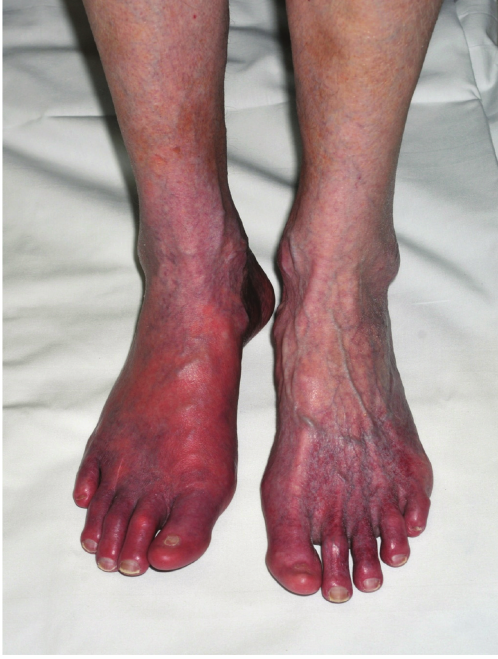
Figure 1: Before initiation of aspirin.